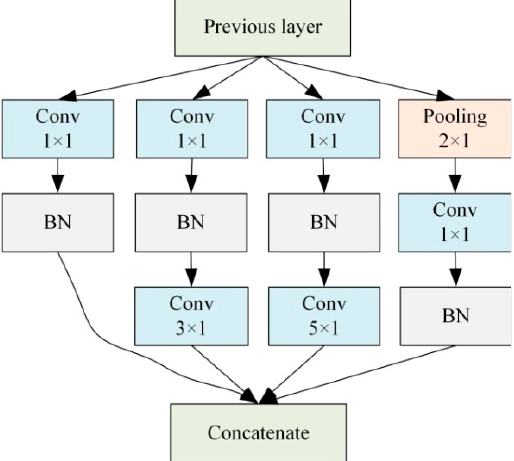
Figure 4. The schematic diagram of inception module.